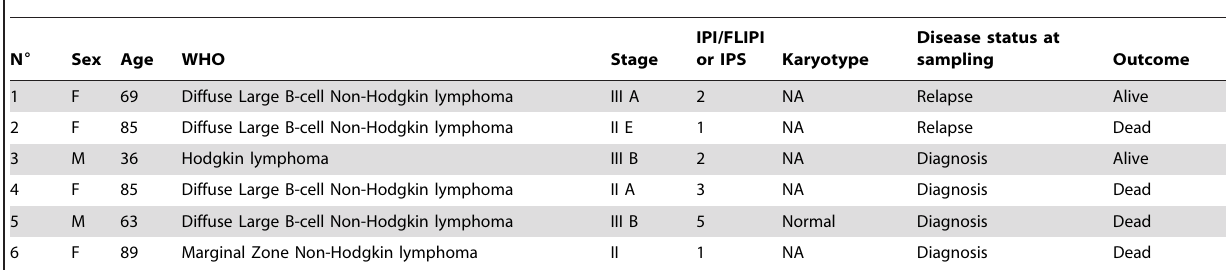
Table 1. Clinical data in patients with Lymphoma.